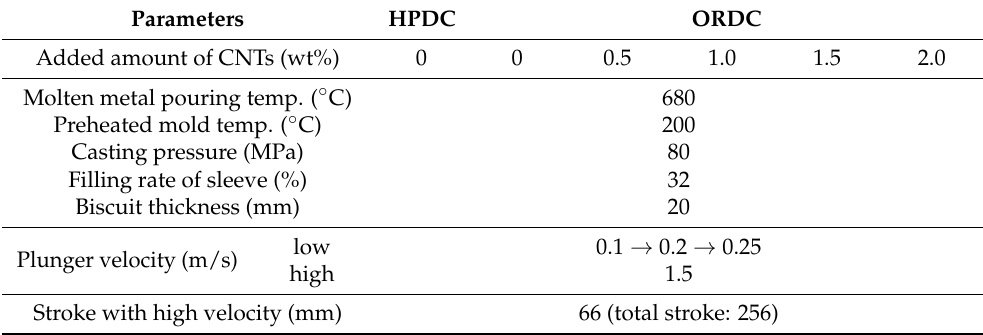
Table 2. Casting conditions of HPDC and ORDC processes.